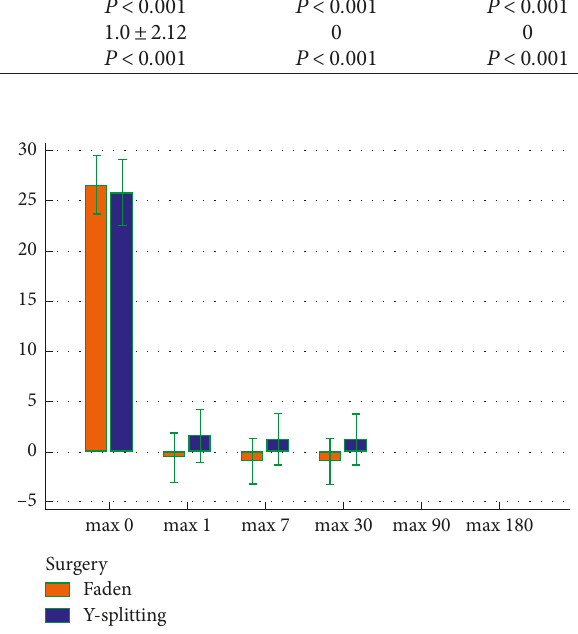
Figure 4: Preoperative and postoperative maximum strabismus angles in both